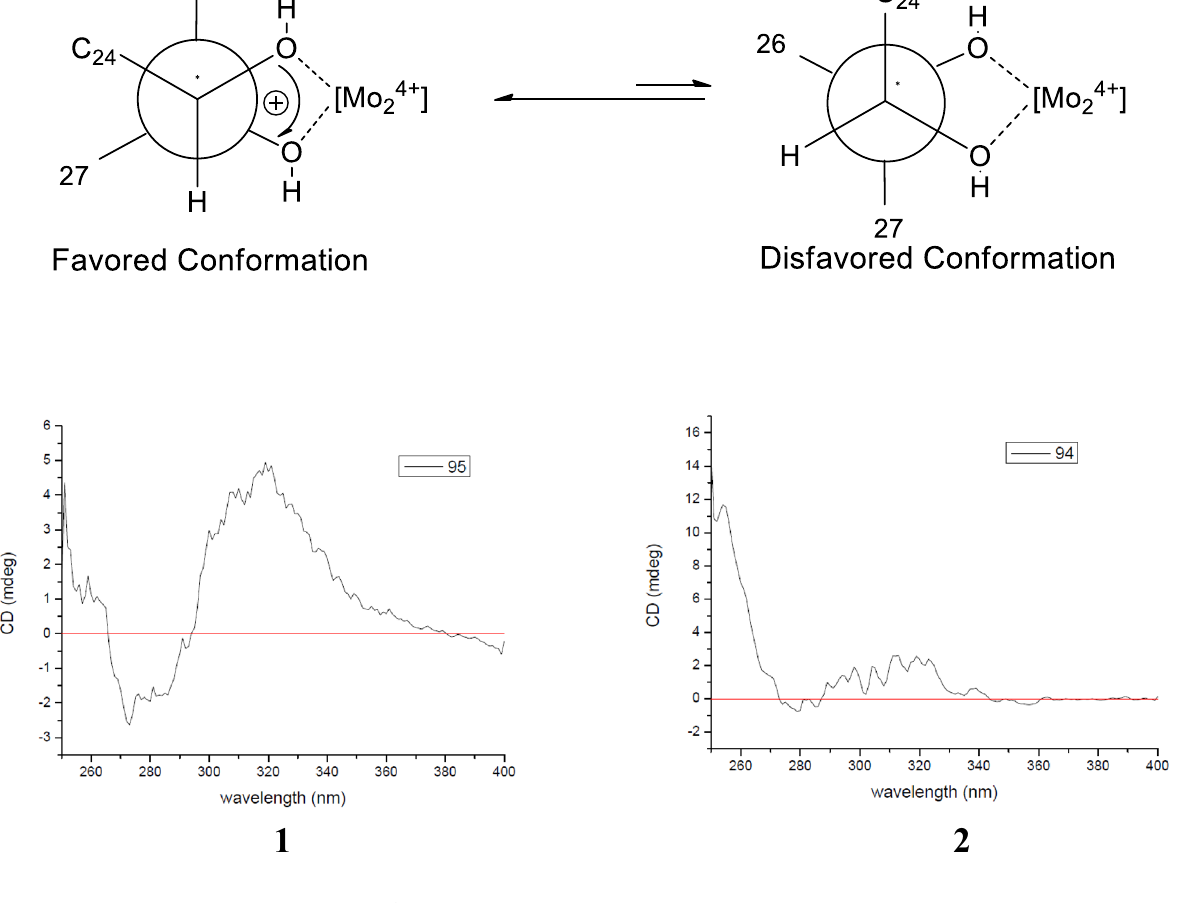
Fig. 4 Conformations and ICD spectra of the Mo 24+ complex of 1 and 2 in